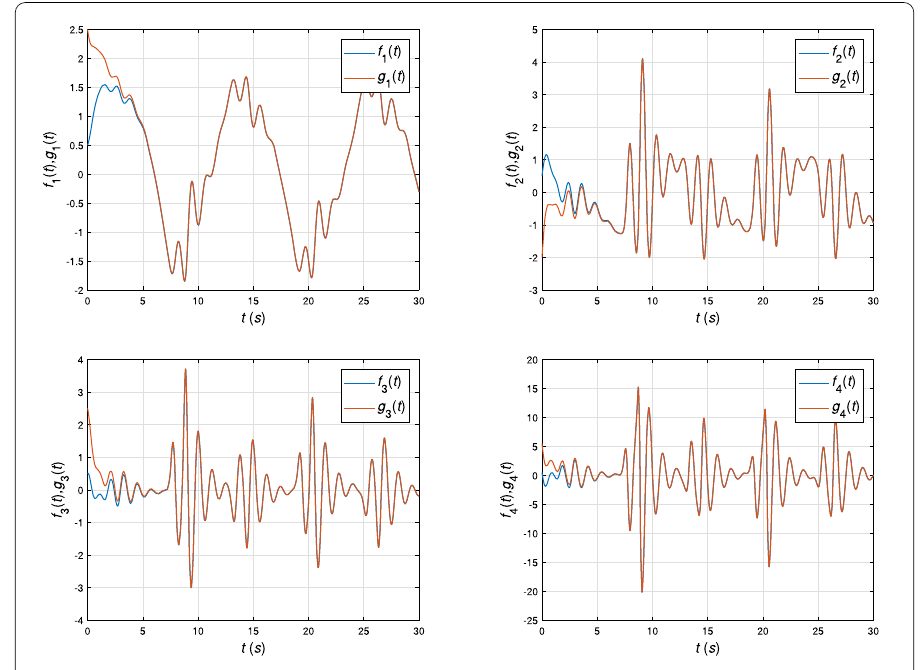
Figure 17 The state trajectories of the synchronized systems (19) and (20) for q = 0.98